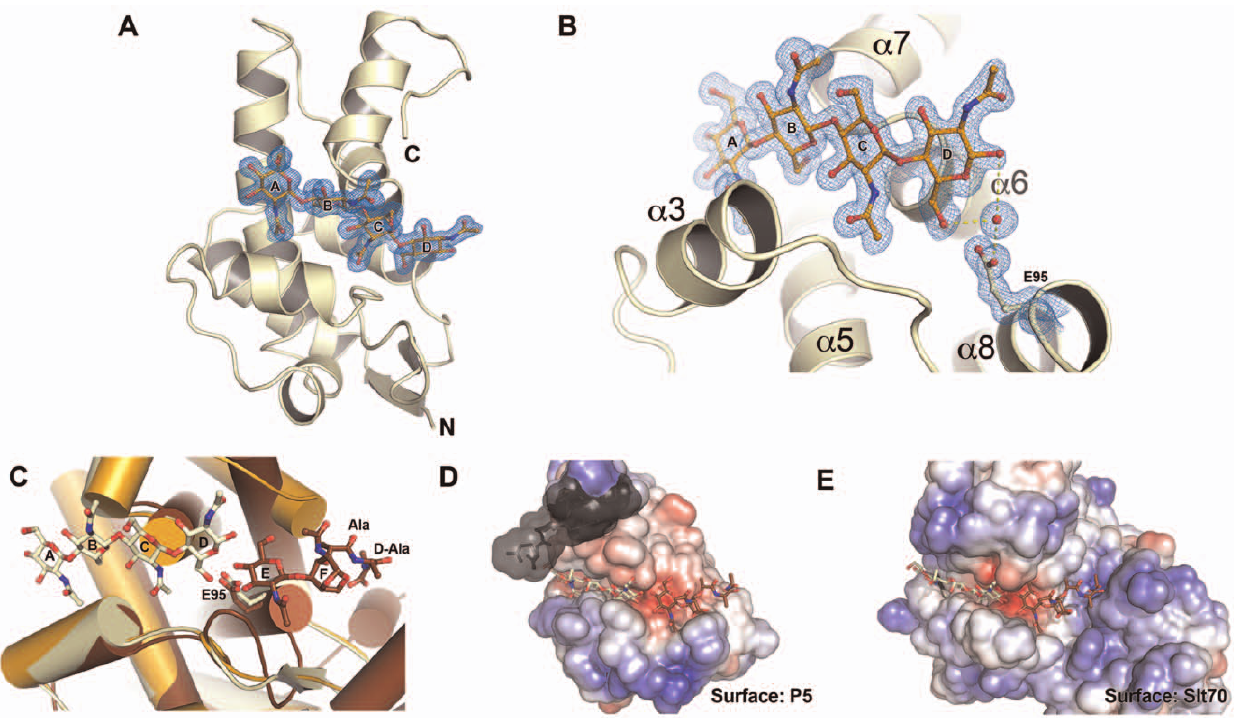
Figure 4. The structure of P5 bound to a glycan suggests lytic transglycosylase activity. A) Overall structure of P5 D V8 wt bound to chitotetraose. The 2F o - F c electron density map for the ligand is shown contoured at 1 s . Residues 199–220 are disordered. Helix a 7 and the following linker are in slightly different positions than in the unliganded structure (see also Figure S3). The four NAG residues of chitotetraose bind to subsites A–D. B) Close-up of the active site. A water molecule is observed between Glu95 and the NAG in subsite D, supporting a lytic transglycosylase (LT) activity, with Glu95 as the catalytic acid/base. C) Superposition of ligand-bound P5 D V8 wt (yellow) and apo-P5 D V8 wt (orange) onto the structure of the E. coli slt70 LT (brown) containing a glycan product in subsites E and F (PDB 1QTD). The geometry and electrostatics of the P5 substrate-binding surface (D) are similar to those of slt70 (E). P5 residues displaced by the chitotetraose ligand are shown in grey with a semi- transparent surface.